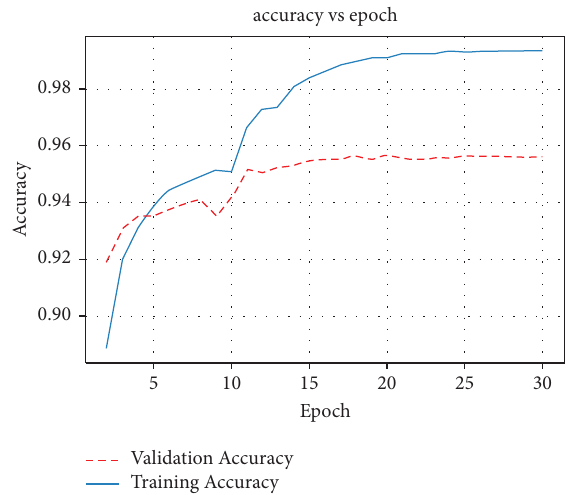
Figure 9: Observed accuracy for case 4.